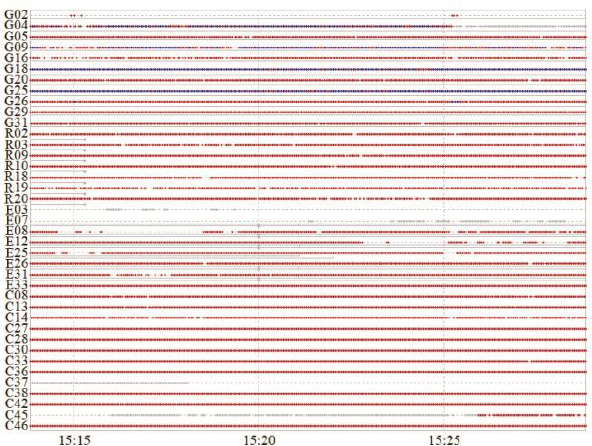
Figure 10 . The satellite visibility for the kinematic car-borne experiment.